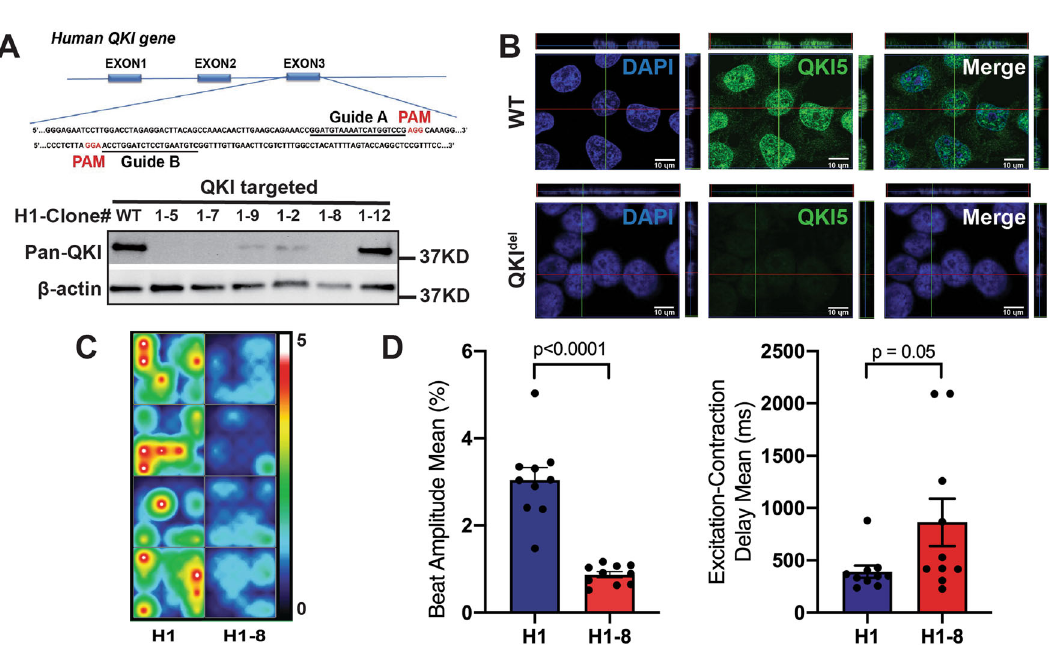
Fig. 2 The generation and characterization of hESCs -QKI del . A Schematic diagram of the exon 3 targeting site for designing guide RNAs using the CRISPR/Cas9 strategy and a representative Western blot screening for positively targeted clones, which is con fi rmed by additional two repeats of western blottings and followed by sequencing con fi rmation. B Representative confocal images of immuno fl uorescence staining con fi rming the genetic ablation of QKI-5 . No detectable positive QKI-5 expression was found in mutant H1-8 cells, whereas there was strong nuclear QKI-5 expression (green fl uorescence signal) in control H1 cells. Three independent sets of cells are used in the analysis and the fi nding is consistently con fi rmed. C Representative heatmap of Maestro-MEA assay for contractile function comparing Day-30 cardiomyocytes derived from control hESCs (H1) and hESCs- QKI del (H1-8). D Comparison of the relative contractility and the excitation – contraction delay between Day-30 cardiomyocytes derived from control hESCs (H1) and hESCs- QKI del (H1- 8). Signi fi cantly reduced contractility and prolonged E – C delay in cardiomyocytes derived from hESCs- QKI del when compared to cardiomyocytes derive from control hESCs. Data are shown as the mean ± SEM and statistical signi fi cance was determined by a two-tailed Student ’ s t